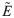
Model calibration overview.Simulations were performed with a center-based model (CBM). In step 1, the contact forces in CBM were calibrated from DCM simulations with parameters (Ecor, hcor, K), yielding a variable effective contact stiffness E˜ of the CBM for each individual cell depending on the compression level. In step 2 the parameters {PC=CT26} of the CBM for cell line CT26 were determined. Comparing simulations of the CBM with stress-free growth of multicellular CT26 spheroids in experiment I determines most parameters of {PC=CT26} (Fig 1B, full black line). step 3: those cell-line parameters that are affected by the capsule, are specified by comparison with the data from experiment I in presence of the thin capsule. The set of experiment-specific parameters {PExp=1} (Young modulus and thickness of the capsule) are given by the experimental setting. For the so specified complete set of parameters the simulation reproduces the experimental data I for the thin capsule (Fig 1B, dashed black line), and, after replacement of the capsule thickness, predicts the experimental data for the thick capsule (see Fig 5B). For CT26 cells growing in experiment setting II the cell parameters remain unchanged {PC=CT26}. The deviation of the growth dynamics of stress-free growth from an exponential in experiment II (Fig 1B, full red line) is taken into account by an experiment-specific parameter, namely the proliferative rim. Without any further fit parameter, the model then predicts the correct growth dynamics subject to dextran-mediated stress (Fig 1B, dashed red line). In order to predict the stress-affected growth kinetics of the cell lines j = {CT26, AB6, HT29, BC52, FHI}, their cell cycle duration is modified to capture the stress-free growth analogously to that of CT26 cells in experimental setting II (Fig 1D–1G, full red lines). After determining the parameters, the growth kinetics of these cell lines subject to stress could be predicted (Fig 1D–1G, dashed red lines).